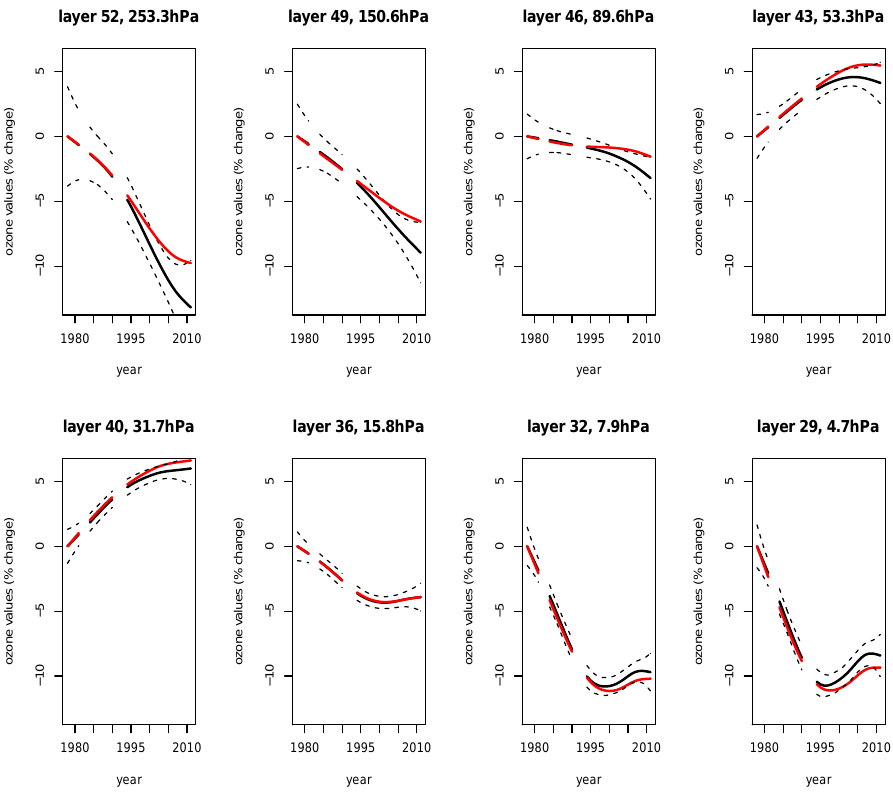
Fig. 16. Estimated ozone trends as % changes in Arosa at selected layers, with 95% confidence intervals. The trends from the full regression model are in black solid lines together with their 95% confidence intervals in dotted lines. The trends from the regression model without EP flux are in red solid lines. Volcanic years are omitted from the trend analysis.